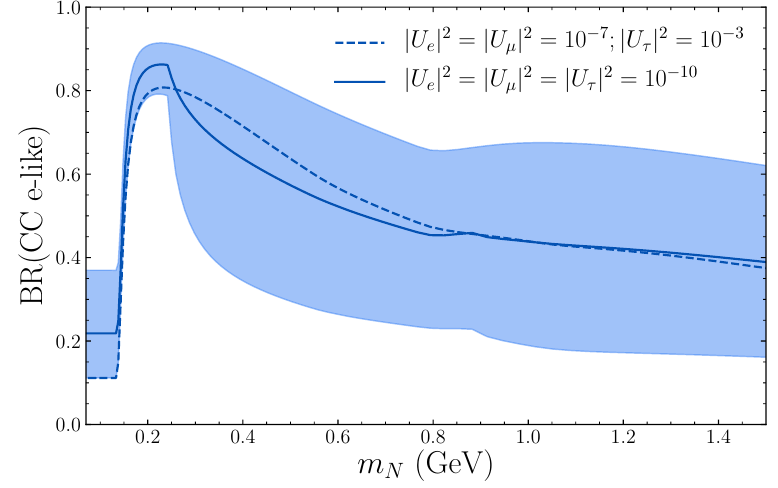
Figure 7 . Value of the branching ratio of the HNL into e-like (cid:12)nal states, de(cid:12)ned in eq. (4.8), as a function of its mass. The lines correspond to (cid:12)xed values of the mixing with the light neutrinos as indicated by the labels, while the shaded areas show the range of branching ratios accessible by varying independently the mixing matrix elements within the following limits: 10 (cid:0) 10 < j U e j 2 < 10 (cid:0) 7 , 10 (cid:0) 10 < j U (cid:22) j 2 < 10 (cid:0) 7 and 10 (cid:0) 10 < j U (cid:28) j 2 < 10 (cid:0) 4 . For illustration purposes, we have